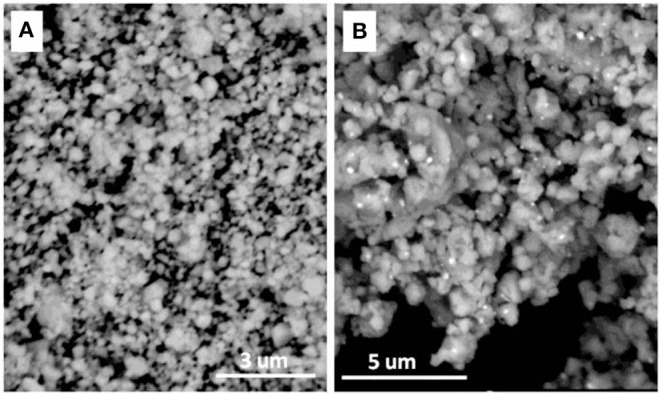
BSEM image of (A) the as-oxidized CeH2.73/CeO2 composite (S5) and (B) the ball-milled Mg2NiH4 + S5 sample.